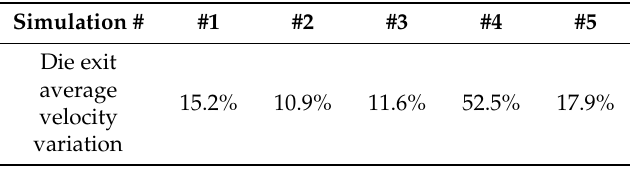
Table 4. Die exit average velocity